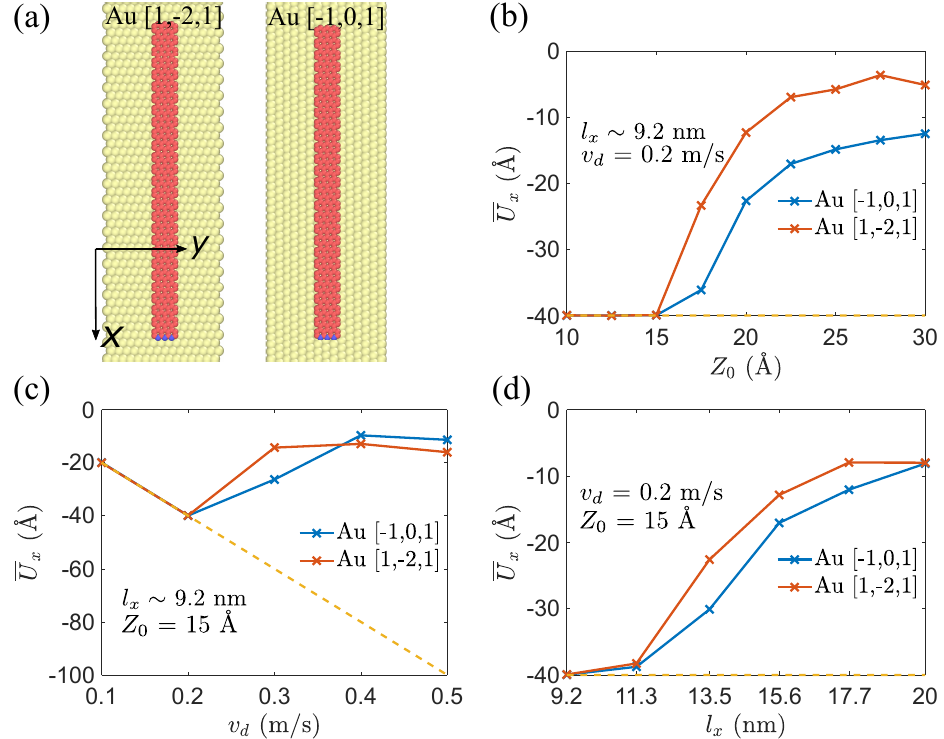
Figure 8. ( a ) Schematic of two orientations, GNRs on Au [1, −2, 1] and Au [−1, 0, 1] crystallographic directions; ( b – d ) variation of displacement U x of tail atom for different orientations with respect to dragging velocity v d , lifting height Z 0 , and length l x at time of 30 ns. Dotted lines represent the displacements of virtual